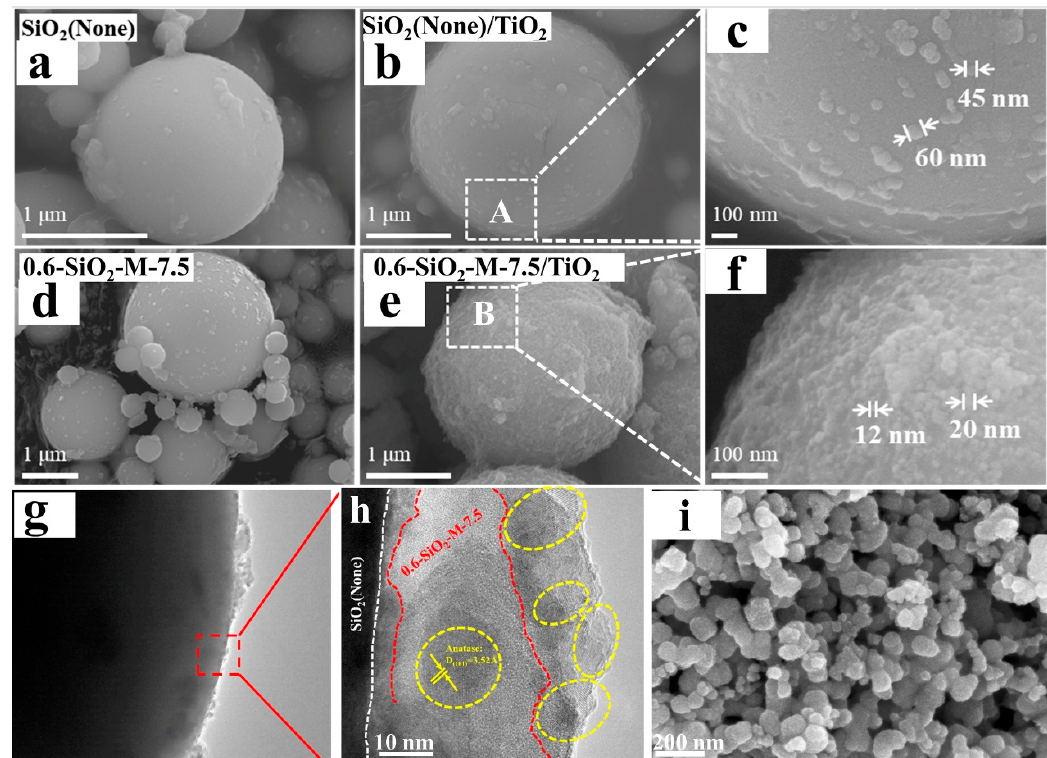
Figure 7. ( a – c ) SEM images of SiO 2 and SiO 2 /TiO 2 ; ( d–f ) SEM images of 0.6-SiO 2 -M-7.5 and 0.6-SiO 2 -M-7.5/TiO 2 ; ( g , h ) TEM images of 0.6-SiO 2 -M-7.5/TiO 2 ; ( i ) SEM of TiO 2